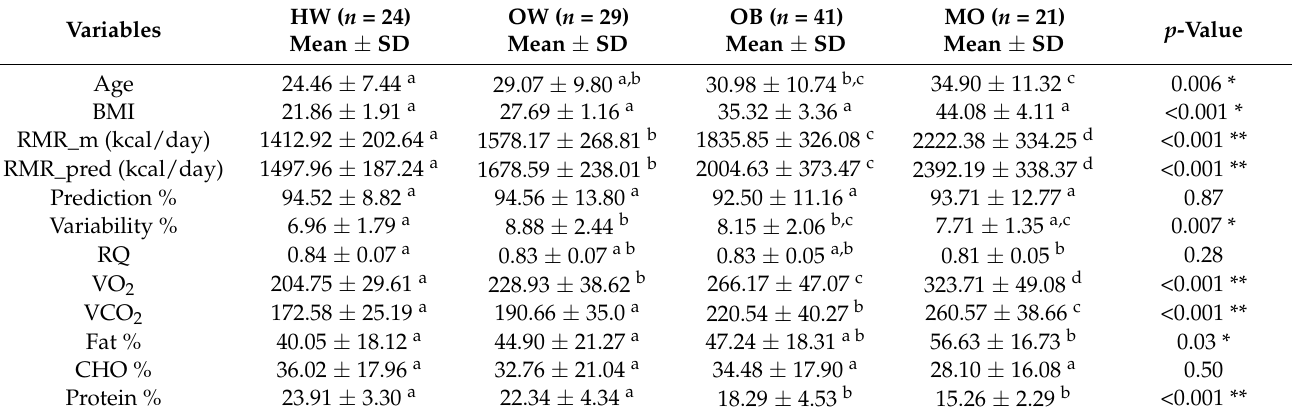
Table 2. Mean differences in indirect calorimetry and other descriptive data stratified by subgroups, n =